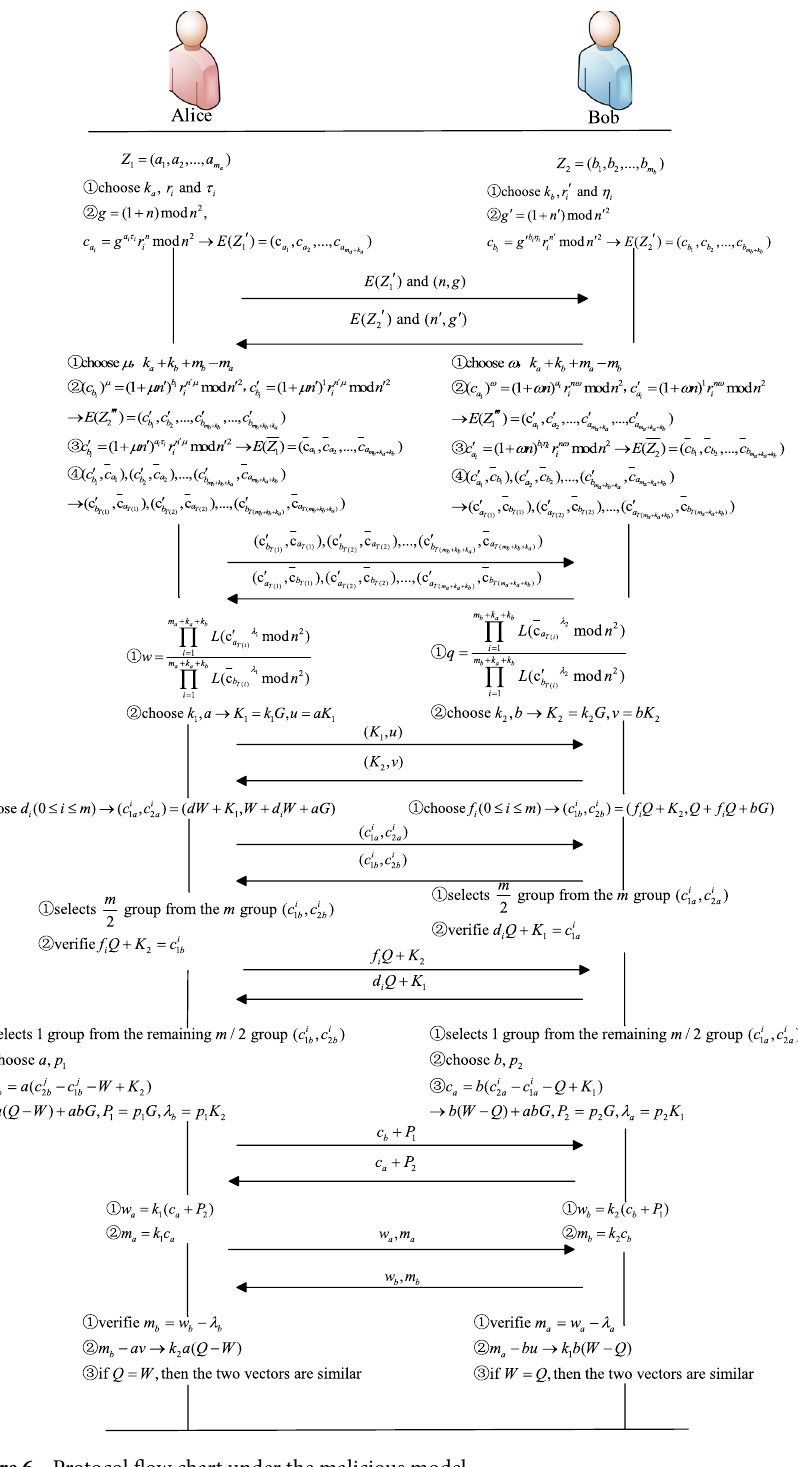
Figure 6. Protocol flow chart under the malicious